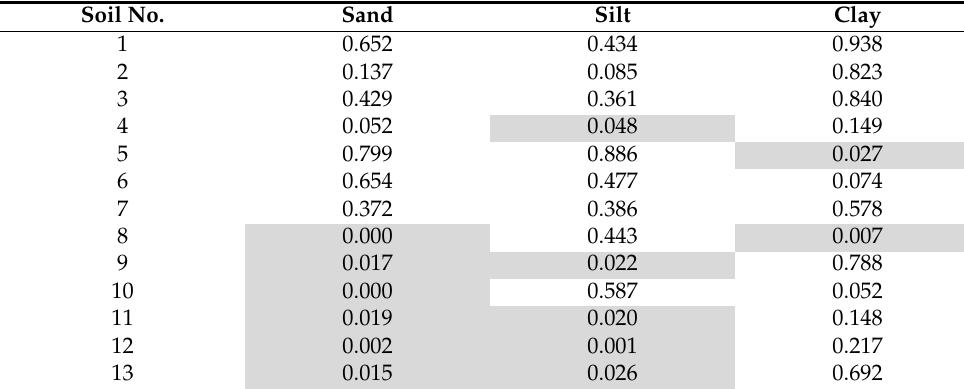
Table 3. Results of the Shapiro—Wilk normality tests. Highlighted results (grey color) indicate cases for which there was no normal distribution (n = 30; p ≤ 0.05). Soil No. Sand Silt